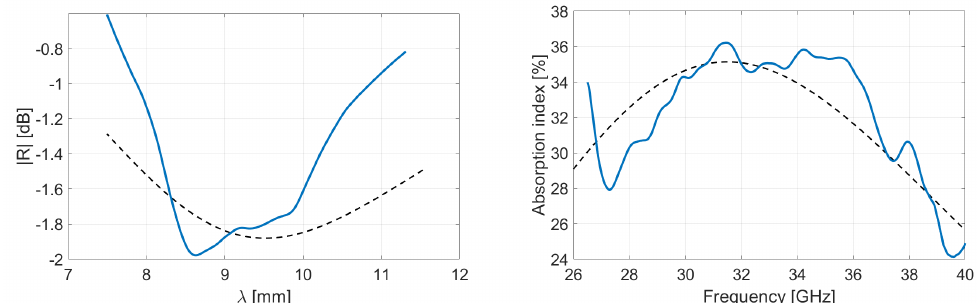
Figure 14. Reflectivity and absorption performances of the hybrid Salisbury structure. The resistive layer is rPLA–4%OMMT 200 µm-thick film and the lossy material is VPLA 1.2 mm-thick. The dotted line is the simulation of the performance based on material